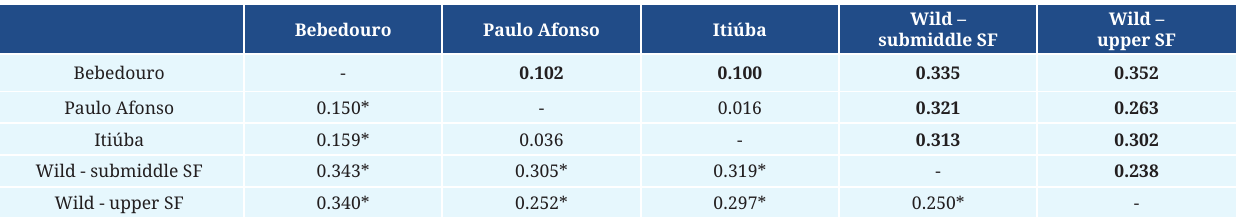
TABLE 3 | Estimated pairwise F alexandri .